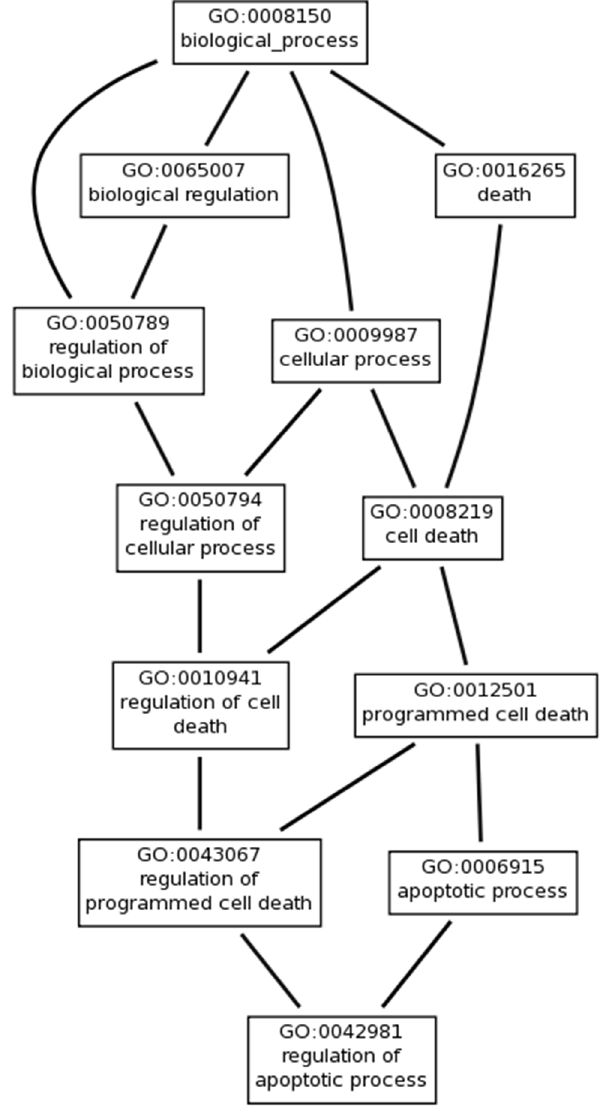
Figure 6. Gene Ontology tree of apoptosis-related GO categories. These GO categories were significantly enriched by genes which were differentially regulated in TNF- a and GM-CSF treated